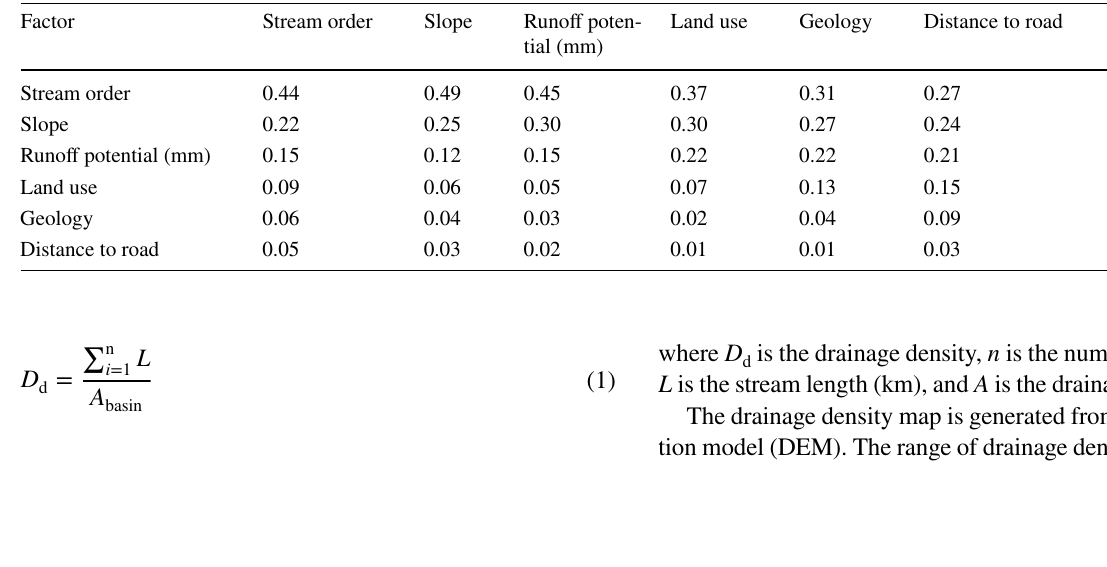
Table 8 Determined relative criterion